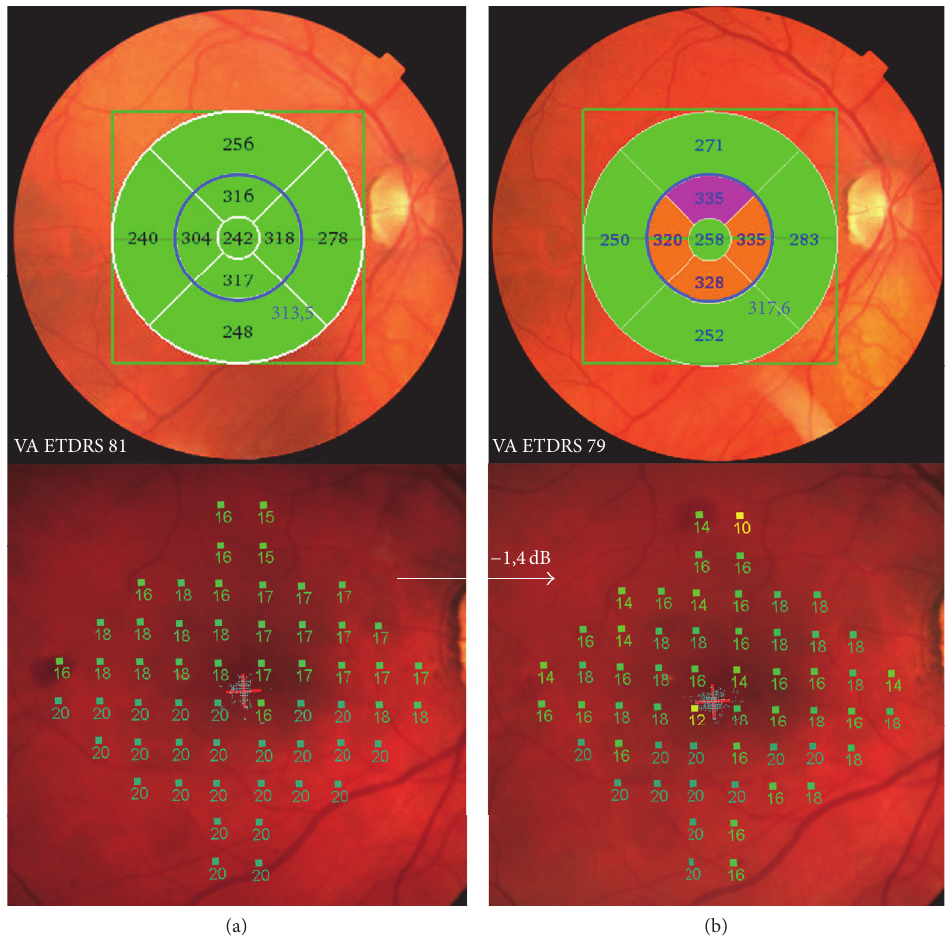
Figure 5: Investigations of a 58-year-old diabetic patient. (a) One month postoperatively: above mean thickness in the central 5-field macular area at OCT (blue circle), BCVA, and below microperimetry sensitivity. (b) Six months postoperatively: above increased mean thickness in the central 5-field macular area at OCT (blue circle), decreased number of ETDRS letters of BCVA, and below microperimetry mean sensitivity decrease